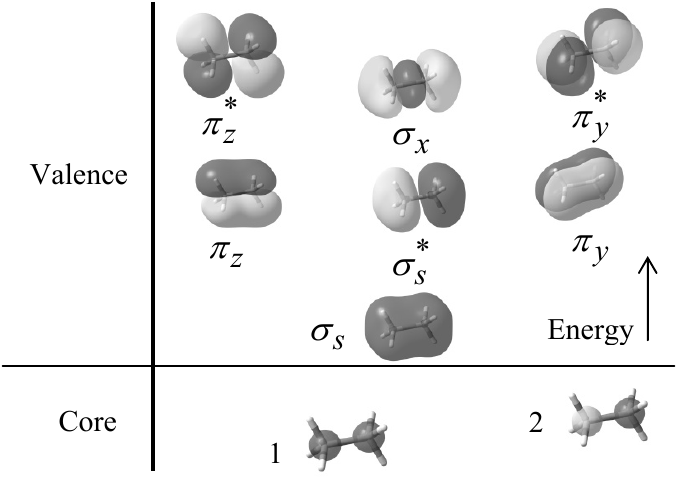
Figure 1. Filled molecular orbitals of ethane calculated with B3LYP/6-31+G(d, p) theoretical